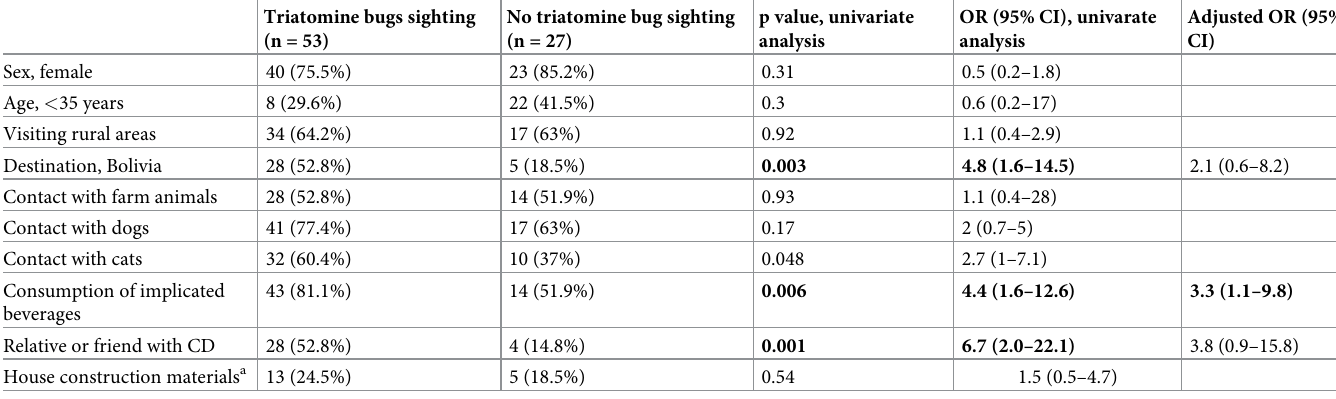
Table 3. Factors associated with self-reporting triatomine bugs